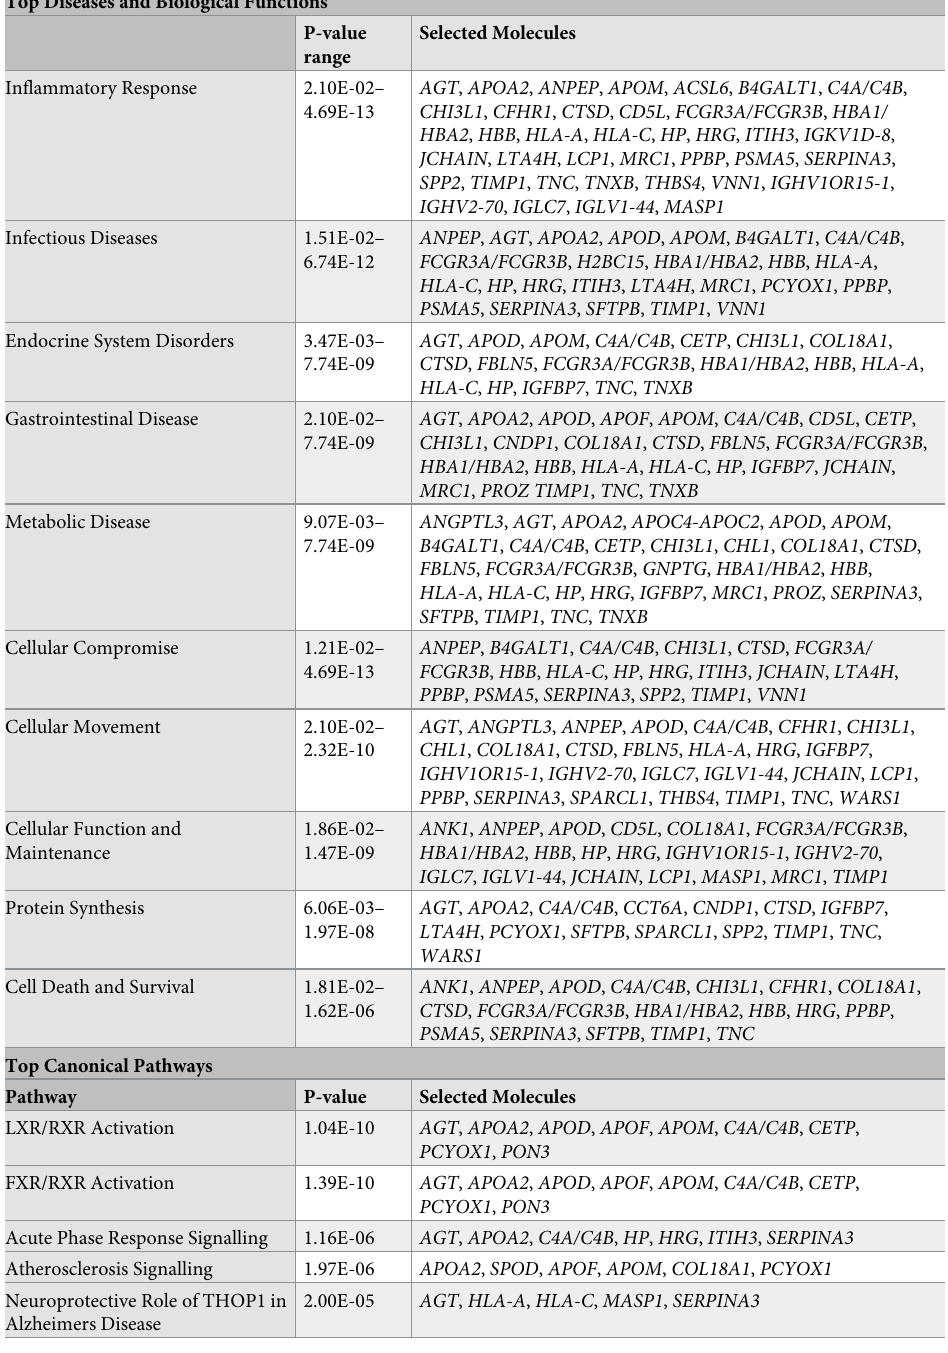
Table 9. Enrichment analysis of proteins associated with COVID-19 severity (all patients). Top Diseases and Biological